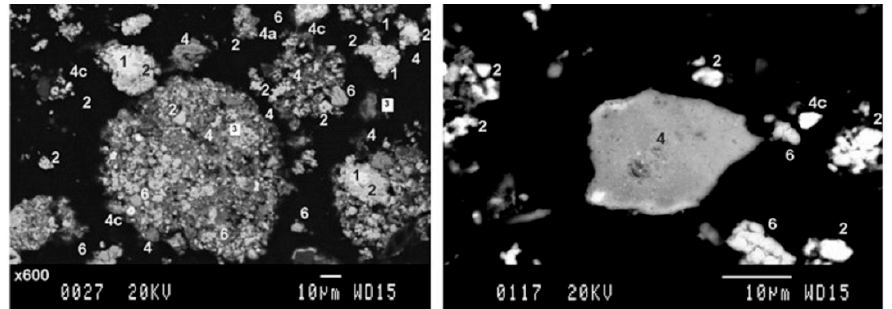
Figure 11. Oxidized O-Sb-Pb (phase 4) (with traces of Cu-Bi-Cl-Ag).